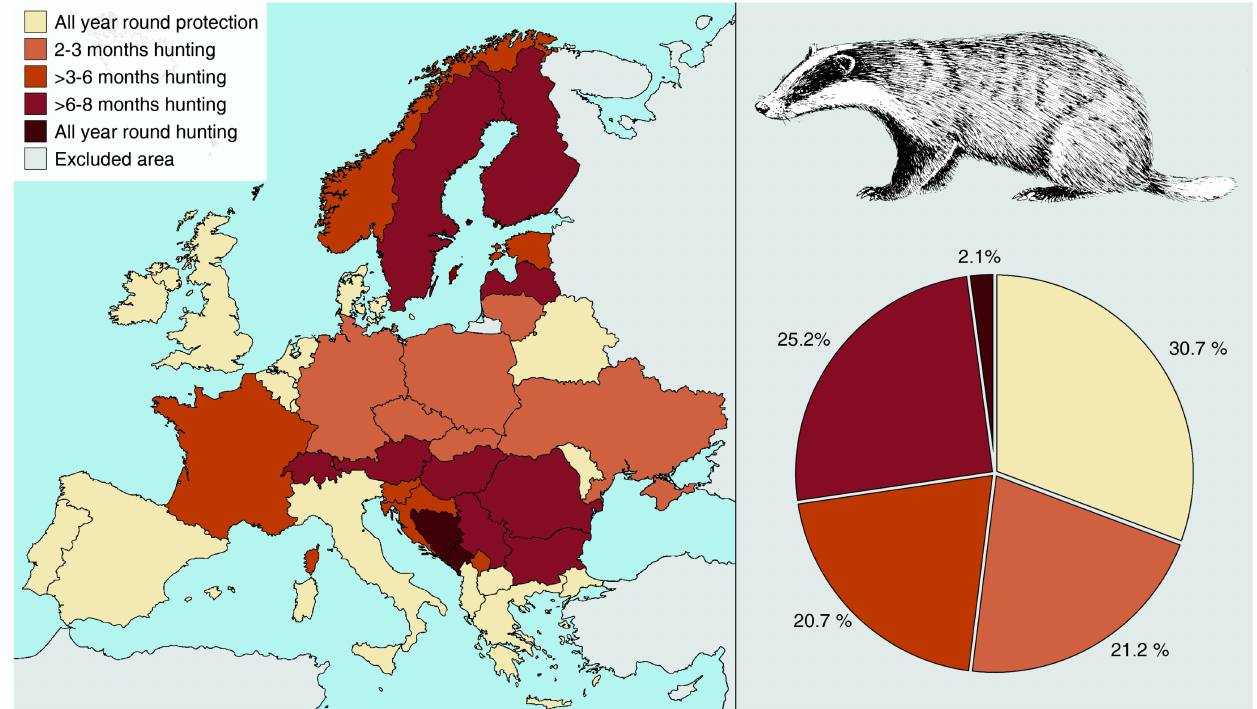
Figure 2. General hunting seasons of European badger Meles meles in Europe. The percentages in the pie chart indicate the range share of a given legal status of the badger. Countries where hunting season differs between regions (Austria, France, Germany, and Switzerland) classified as explained in Methods, more detailed data presented in Table 1. Updated to 30 June